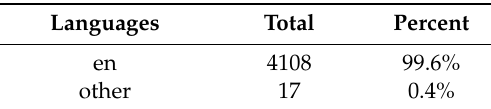
Table A55. Primary languages (uk).